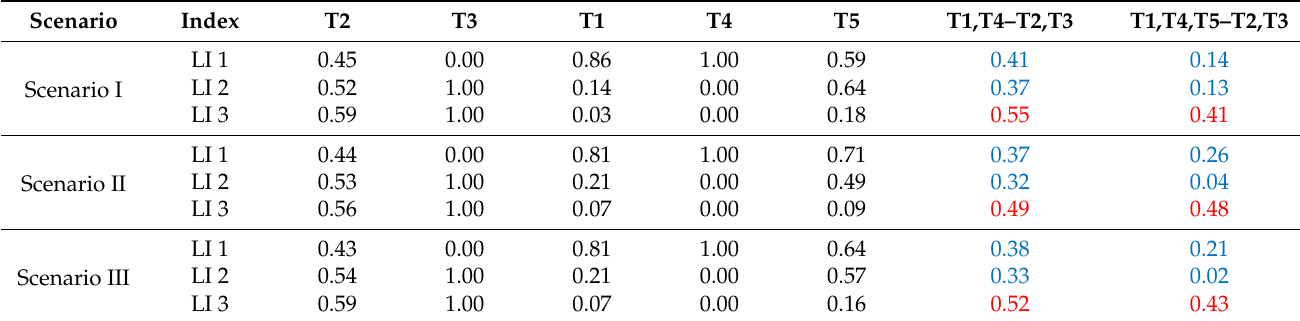
Table A1. Normalized laboratory indices of the averaging scenarios for tree 1–5. The last two columns show the normalized distance between infested (green attack, T1 and T4) and healthy (T2 and T3) spruces (normalized from T1–4) and the normalized distance between infested (T1, T4 and T5) and healthy (T2 and T3) spruces (normalized from T1–5). In the context of the laboratory data, all laboratory indices can be used to differentiate between healthy and infested spruces due to the positive difference. For LI 1 and LI 2, the difference decreases strongly when T5 (infested, brown crown) is taken into account (blue numbers). For LI 3, however, the difference decreases only slightly (red numbers). LI 3 is less prone to misclassification than LI 1 and LI 2 due to the larger difference.